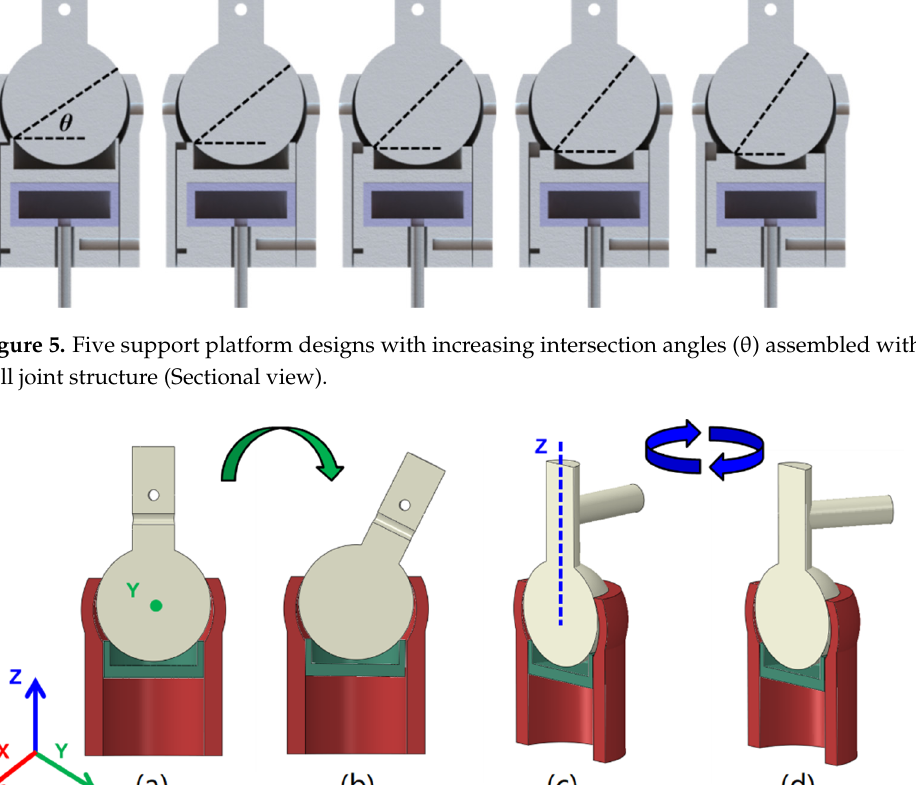
Table 1. The simulation results of the reaction force in both rotating and twisting directions with respect to different intersection angles. θ